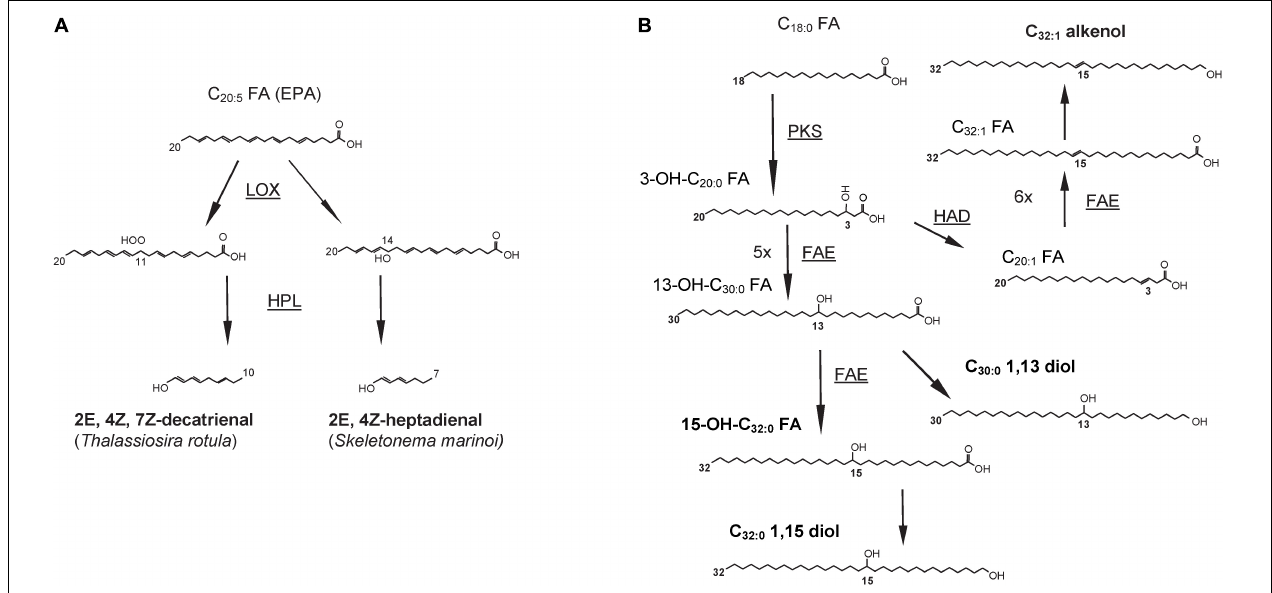
FIGURE 3 | Biosynthetic pathways for (A) decatrienal and heptadienal, two common oxylipins produced by diatoms and (B) three classes of lipids produced by Nannochloropsis spp. and other Eustigmatophyceae: long chain hydroxy fatty acids (LCHFAs), long chain diols (LCDs), and long chain alkenols (LCAs). End products are in bold whereas enzyme names, where known, are underlined and shown next to the arrows. LOX, lipoxygenase; HPL, hydroperoxide lyase; PKS, polyketide synthase; FAE, fatty acid elongase; HAD, hydroxyacyl dehydratase. Figures redrawn from (A) Fontana et al. (2007a) and (B) Balzano et al.